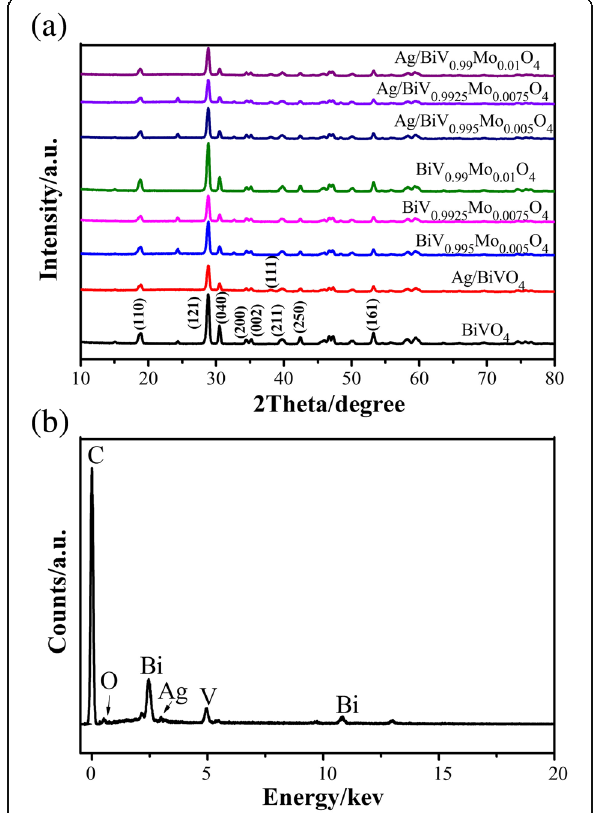
Fig. 1 a XRD patterns of pure BiVO 4 , Ag/BiVO 4 , BiV 1-x Mo x O 4 , and Ag/ BiV 1-x Mo x O 4 . b The corresponding EDX analysis of Ag /BiV 0.9925 Mo 0.0075 O